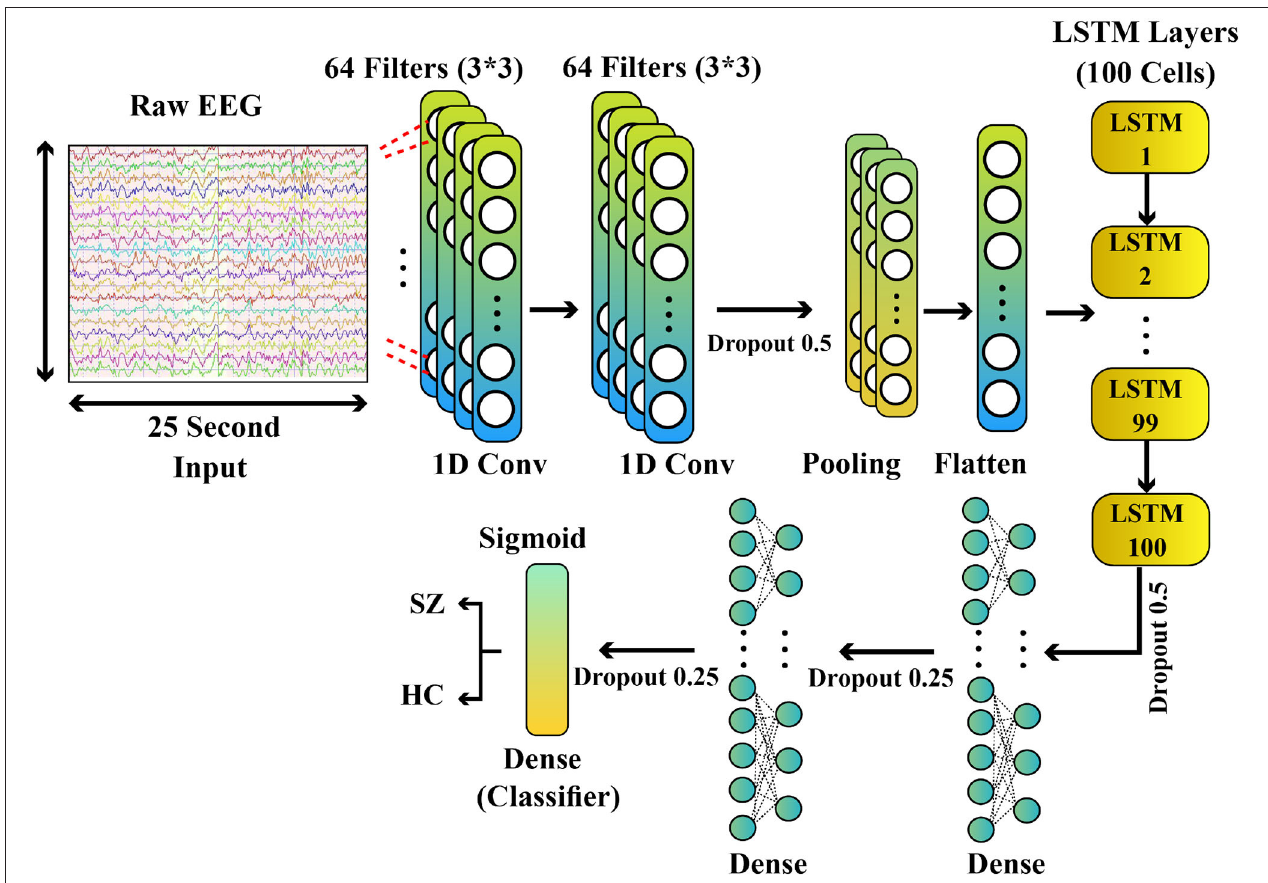
FIGURE 4 | The second version of the proposed CNN-LSTM model for diagnosis of SZ. CNN, convolutional network; LSTM, long short-term memory; SZ,